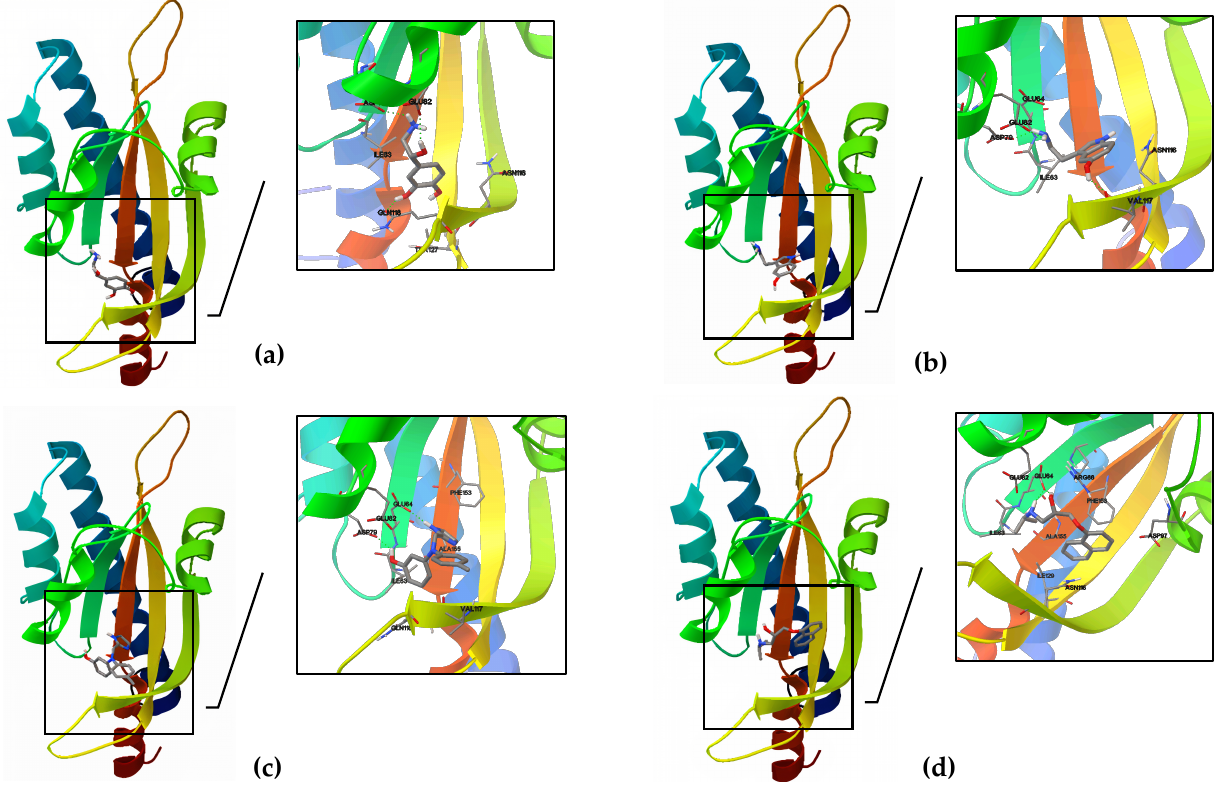
Figure 8. Docking to the putative structure of VicK (WalK) of E. faecium NCIMB10415: ( a ) NE; ( b ) 5HT; ( c ) phentolamine; ( d )